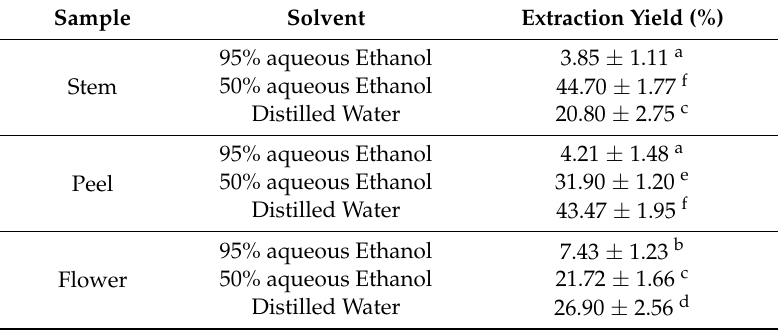
Table 1. The extraction yield for the different parts of Hylocereus polyrhizus